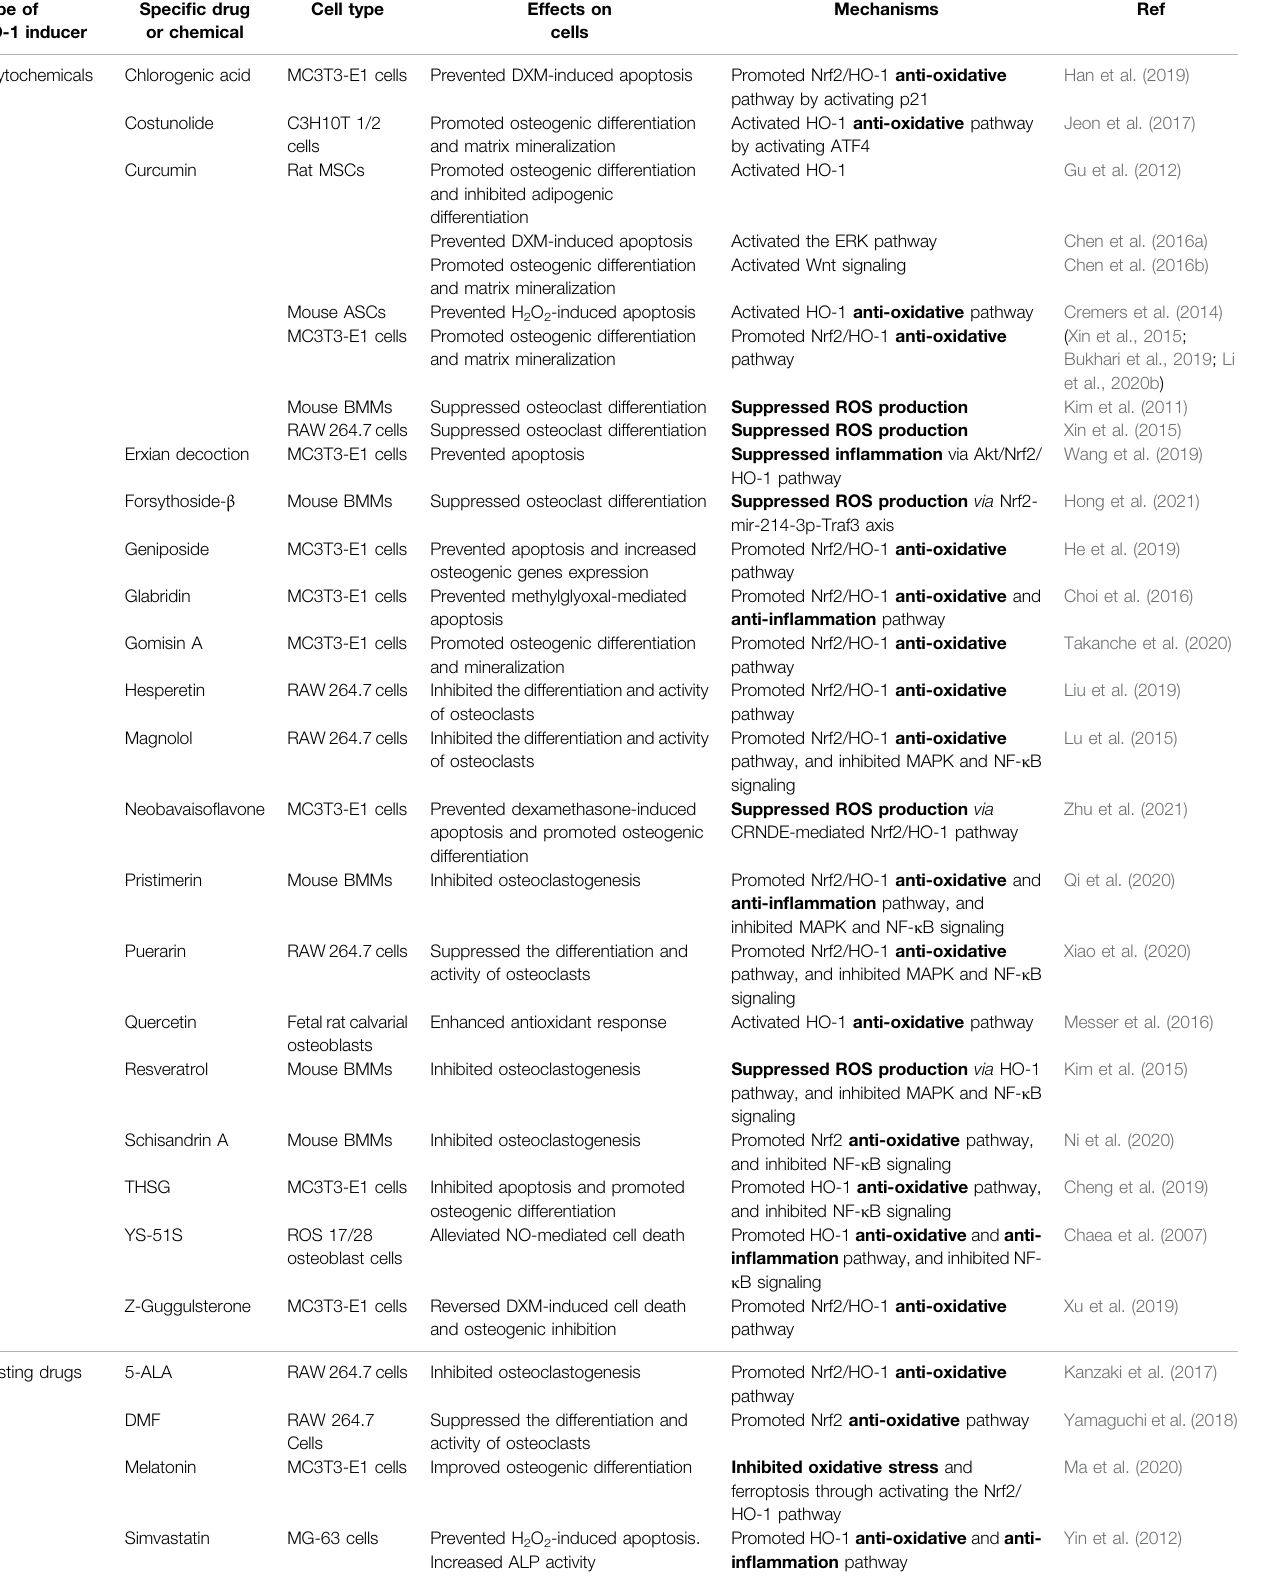
TABLE 1 | Pharmacological treatment towards HO-1 induction for osteoporosis in vitro . Type of HO-1